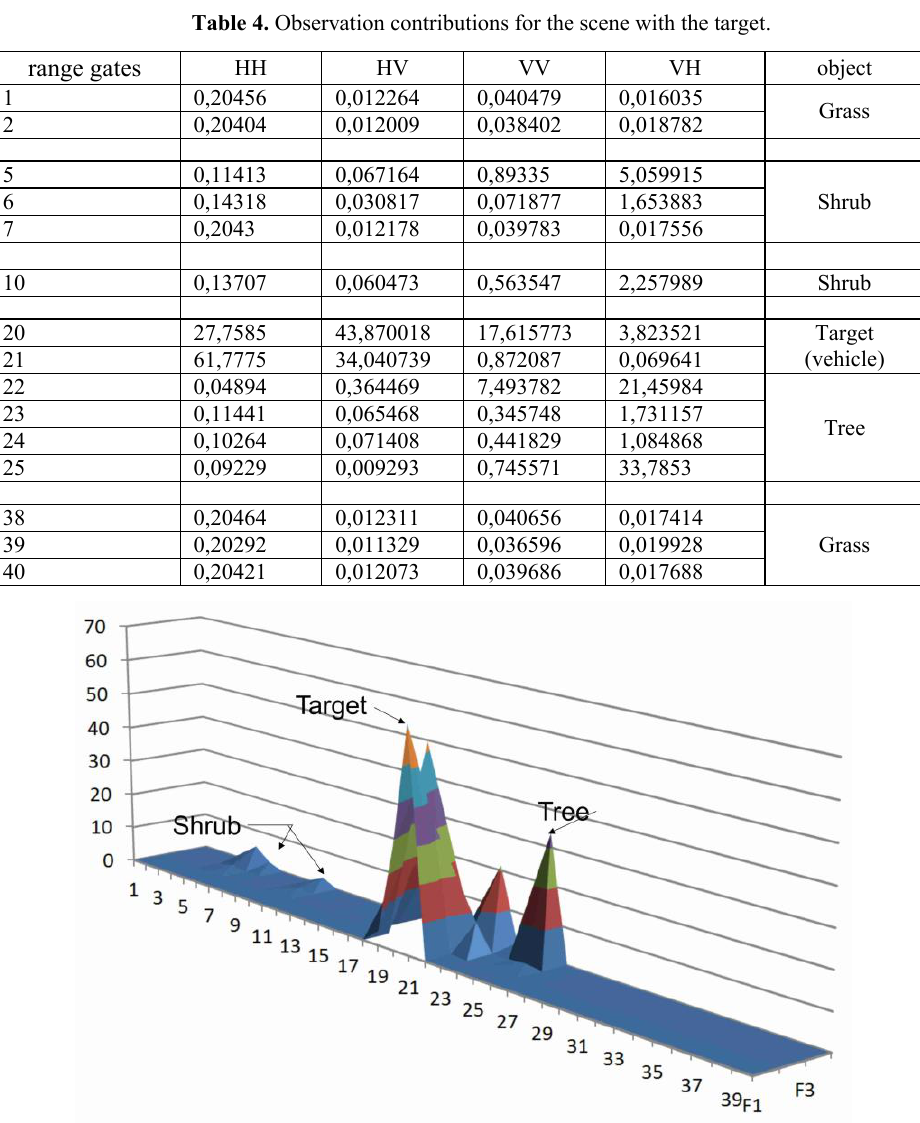
Fig. 4. Observation contributions for the scene with the